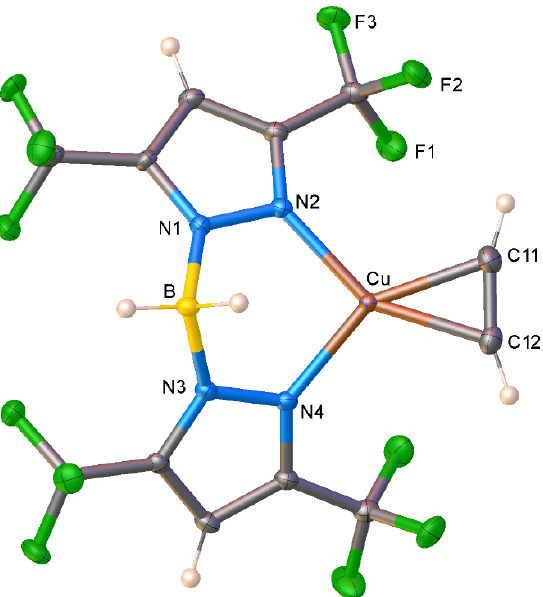
Figure 2. Molecular structure of [H 2 B(3,5-(CF 3 ) 2 Pz) 2 ]Cu(HC ≡ CH) ( 4 ); ORTEP view with 50% prob- ability ellipsoids are shown. Selected bond distances (Å) and angles (°): Cu-N2 1.981(3), Cu-N4 1.981(3), Cu-C11 1.972(3), Cu-C12 1.973(3), C11-C12 1.225(5), B-N1 1.570(4), B-N3 1.569(4), Cu···B 3.046, C11-Cu-C12 36.17(14), N2-Cu-N4 96.63(10), N4-Cu-C12 113.19(13), N2-Cu-C11 114.01(13), N1-B-N3